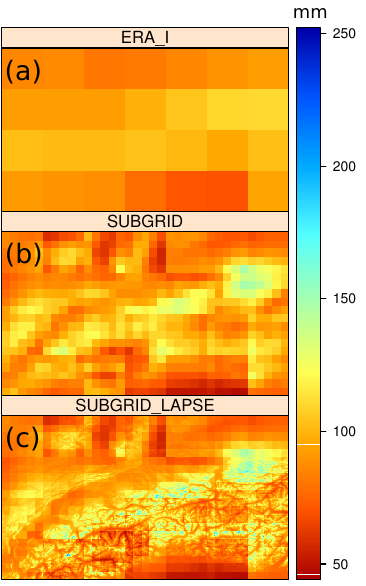
(1) to obtain SW ↓ dir (2) based on 1 z , 1 M grid sub